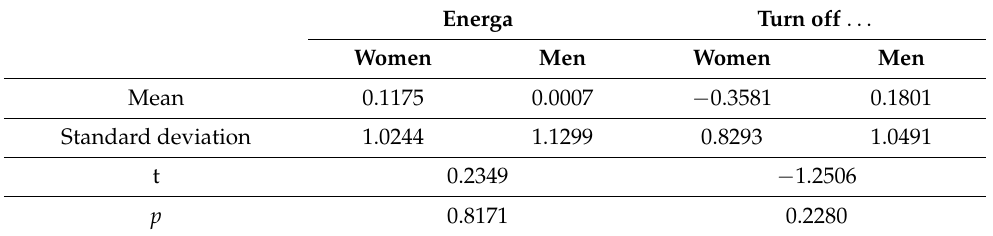
Table 3. Results of t -test for the message assessment in women and men (source: own elaboration). Energa Turn off . .